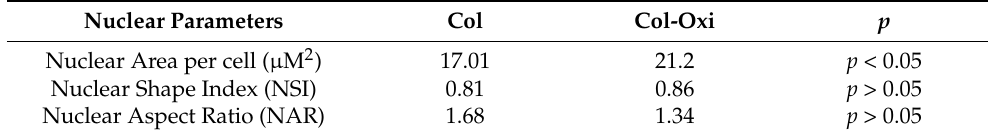
Table 4. Morphometric analysis of ADMSC nuclei adhering to native and oxidized collagen: nuclear area per cell, nuclear shape index (NSI), Nuclear Aspect Ratio (NAR), and corresponding p values.